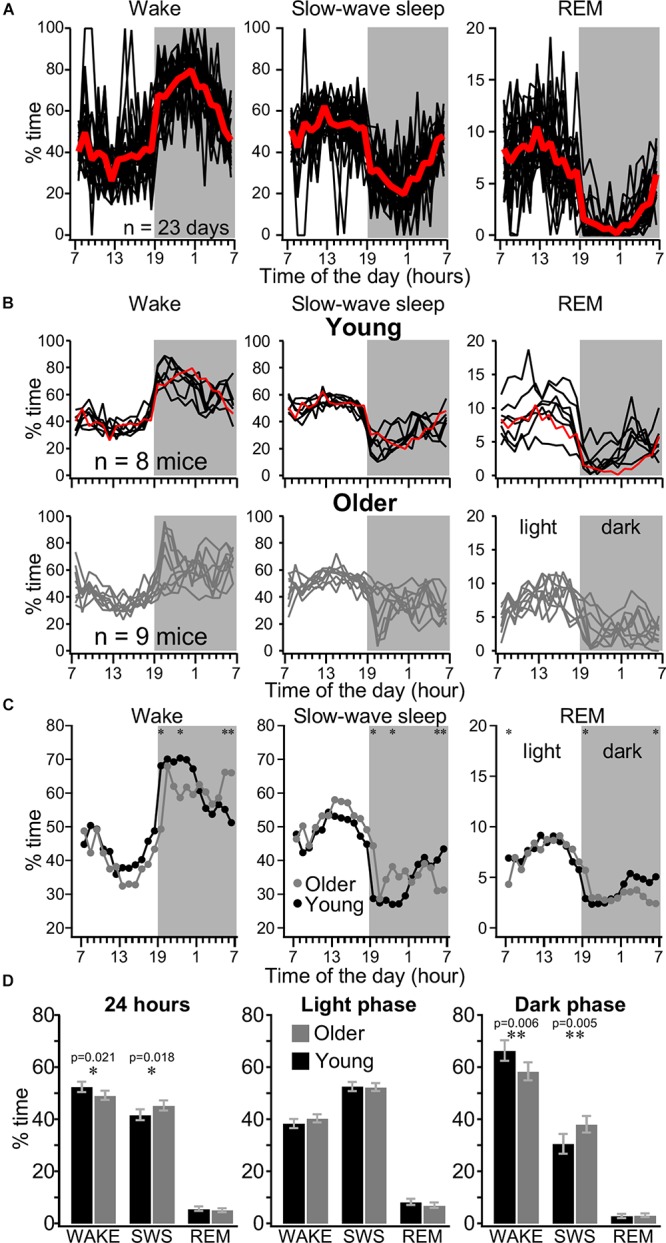
Distribution of sleep–wake states in young and older mice over 24 h. (A) Distribution of wake, SWS, and REM sleep recorded over 23 consecutive days with 1-h resolution in individual mice (black lines) and their average (red line). (B) Distribution of wake, SWS, and REM sleep in young (upper panels) and older (lower panels) mice. Each line represents averaged values of one animal over several days of recordings, the red line is an average from the example mice shown in panel (A). (C) Hourly distribution of states of vigilance for 24 h for young (black circles, n = 99 days from eight mice) and older (gray circles, n = 67 days from nine mice) mice. Shaded area indicates the dark phase. Printed values are estimated marginal means computed in six independent mixed linear models (one for each state of vigilance and phase of light–dark cycle) with age and hour factors. (D) 24 h and light/dark cycle distribution of states of vigilance. Printed values are estimated marginal means from independent mixed linear models. Note that older mice show more SWS than young mice over a day, but this difference occurs mainly during the dark phase. Significant statistical differences in each hour are indicated by asterisk, ∗p < 0.05, ∗∗p < 0.01. Error bars indicate the 95% confidence interval.